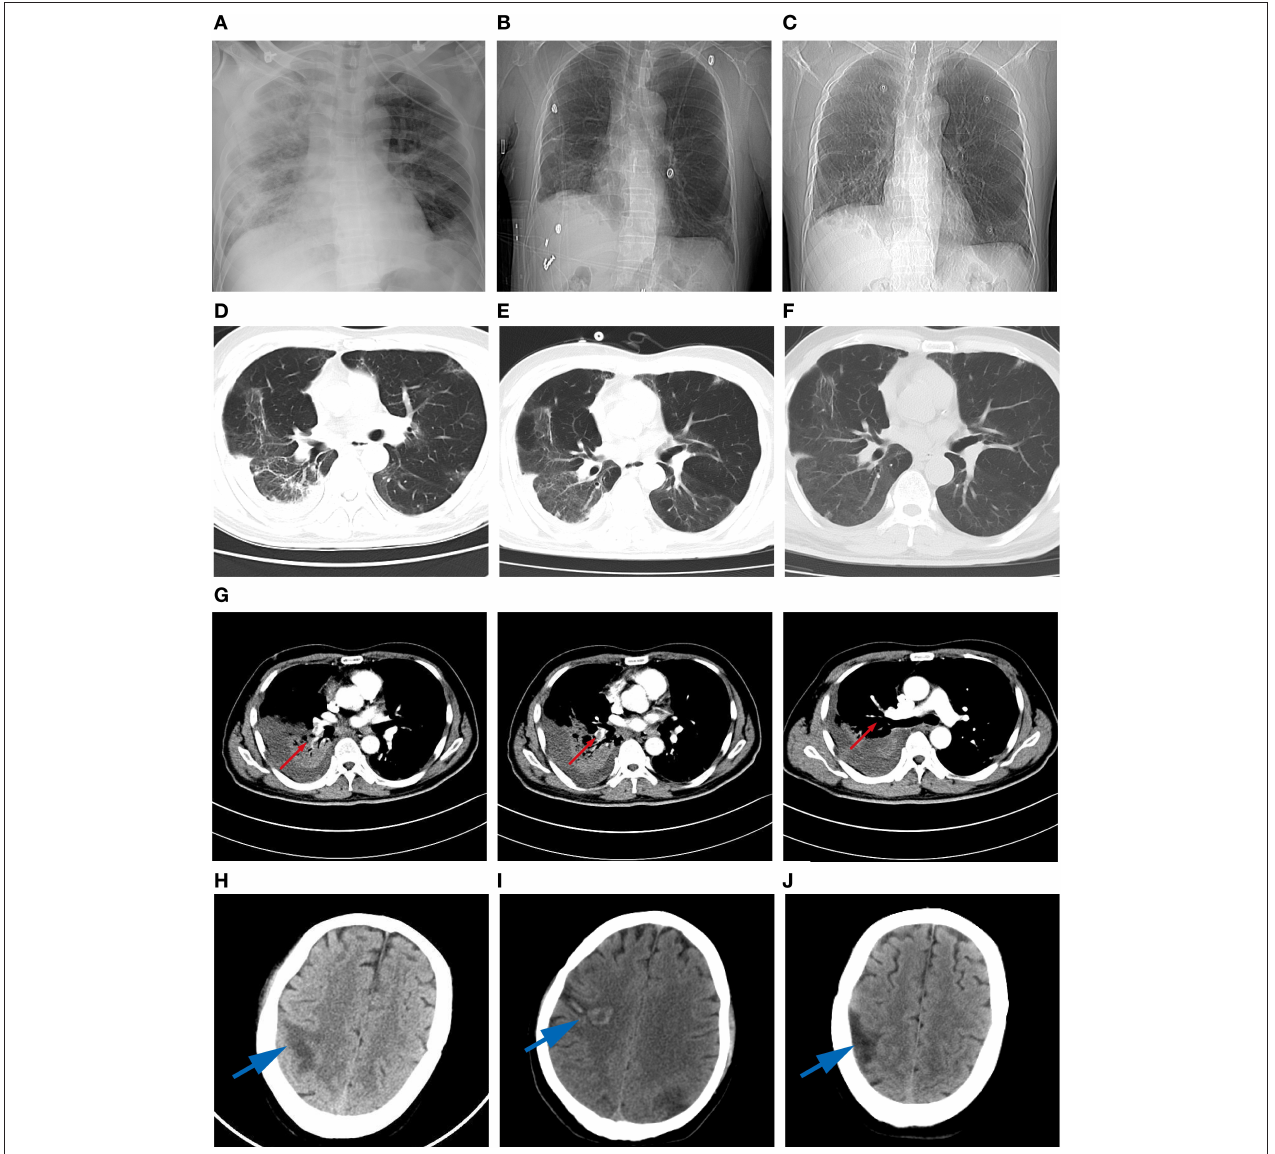
FIGURE 2 | High-resolution computed tomography images during the disease course. (A) chest X-ray image revealing ground-glass opacities (GGO) in the both lobes on day 13 of hospitalization. (B) GGO in the both lobes on day 36. (C) Thickened lung markings in the right lobe on day 44. (D) Multiple-ground-glass opacification in the basal segment of lobes on day 17. (E) GGO in both lower lobes on day 27. (F) GGO in the middle lobe of the right lung on day 44. (G) Filling defect in the trunk and branches of the right inferior pulmonary artery (red arrow). (H) Slightly low-density shadows in the right parietal lobe and the left temporal lobe on day 17 of hospitalization (blue arrow). (I) Hemorrhagic infarction in the right parietal lobe on day 27 (blue arrow). (J) Low-density shadows in the right parietal lobe on day 44 (blue